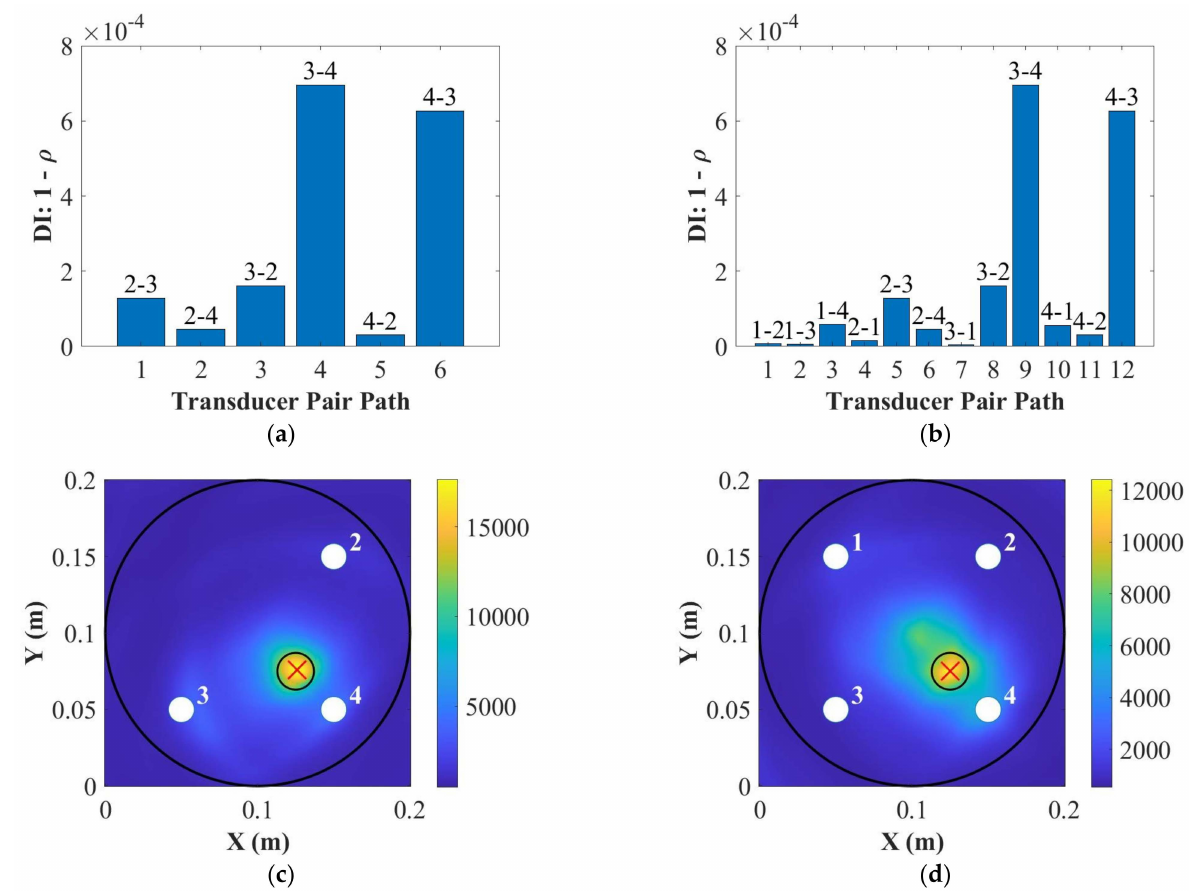
Figure 8. Detection of surface-mounted artificial damage on the surface of the repair patch using ( a ) three PZT transducers and ( b ) four PZT transducers, and localization using ( c ) three PZT trans- ducers and ( d ) four PZT transducers at 250 kHz for the position 2 (where the “ real damage and the “ × ” is the position for predicted